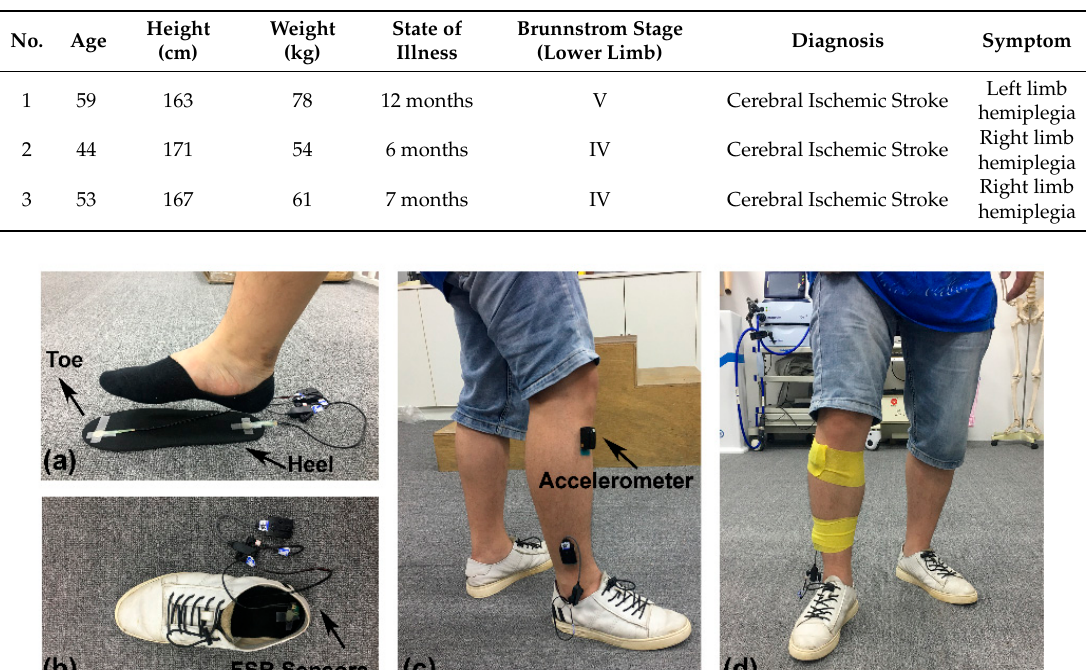
Table 2. Clinical and demographic details of the hemiplegic subjects.